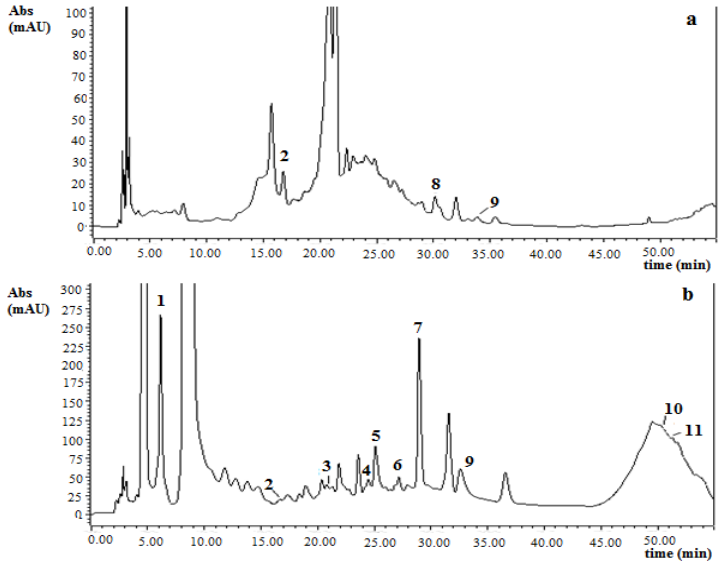
Figure 2. HPLC-DAD chromatograms of a Selva strawberry extract before ( a ) and after ( b ) acid hydrolysis (4 mol/L HCl, 50 min at 90 °C) at 280 nm. Peak identification: 1, gallic acid; 2, (±)-catechin; 3, (−)-epicatechin; 4, ferulic acid; 5, p -coumaric acid; 6, cyanidin; 7, pelargonidin; 8, rutin; 9, ellagic acid; 10, quercetin; 11,